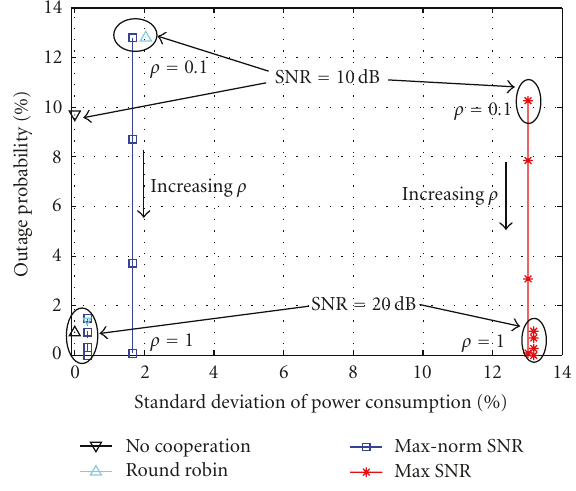
Figure 4: Outage probability versus standard deviation of the power consumption of the di ff erent relay selection mechanisms for di ff erent values of ρ and System SNR ( ρ = { 0 . 1,0 . 5,0 . 8,1 } , K = 5 relays, R = 1bit/s/Hz, d = 100 m. Solid line: System SNR = 10 dB, dashed line: System SNR = 20 dB).